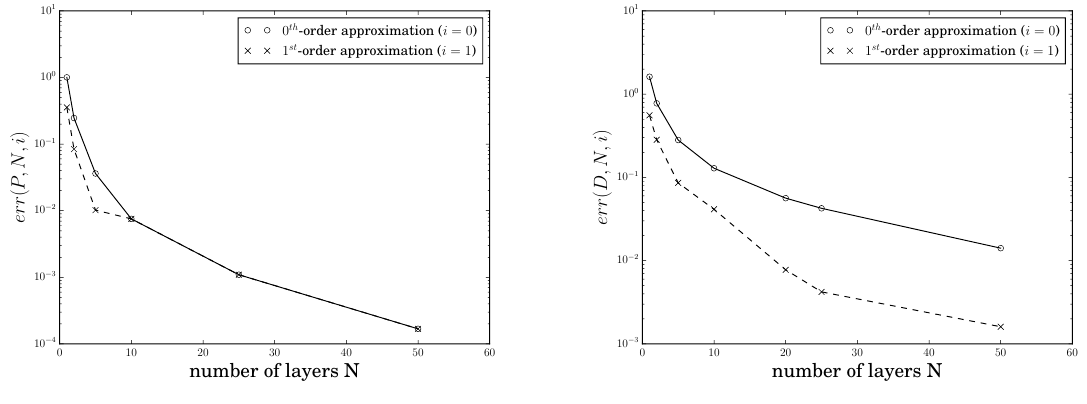
Fig. 6 Relative errors of the 0 th - and 1 st -order approximations of (top) P sw ( Ω 0 ) and (bottom) its derivative D Ω